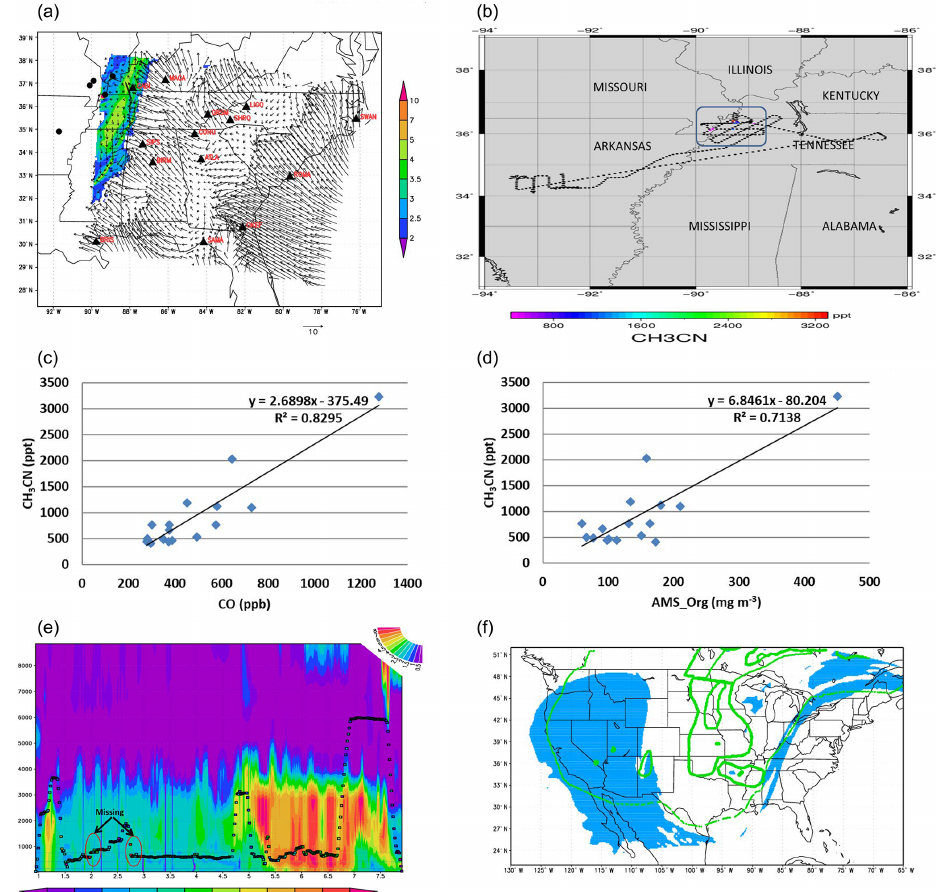
Figure 9. Plots for the 3 July 2013 case: (a) IMPROVE, (b) the flight path of SENEX #0703 colored by measured CH 3 CN concentration (ppt), (c) CH 3 CN (ppt) vs. CO (ppb), (d) CH 3 CN (ppt) vs. AMS_Org (mgm − 3 ) , (e) CMAQ-simulated (cid:49) CO vertical distributions along a flight transect and (f) HMS-observed plume shape versus CMAQ